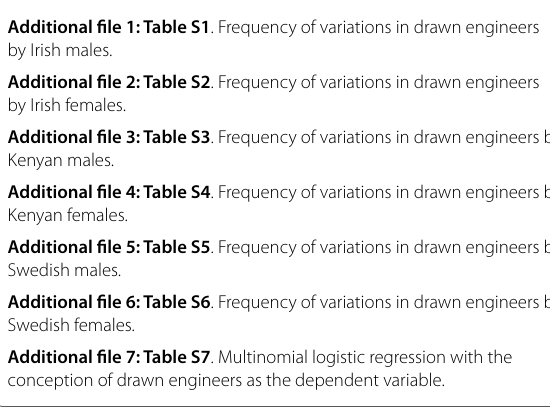
Additional file 2: Table S2 . Frequency of variations in drawn engineers by Irish females. Additional file 3: Table S3 . Frequency of variations in drawn engineers by Kenyan males. Additional file 4: Table S4 . Frequency of variations in drawn engineers by Kenyan females. Additional file 5: Table S5 . Frequency of variations in drawn engineers by Swedish males. Additional file 6: Table S6 . Frequency of variations in drawn engineers by Swedish